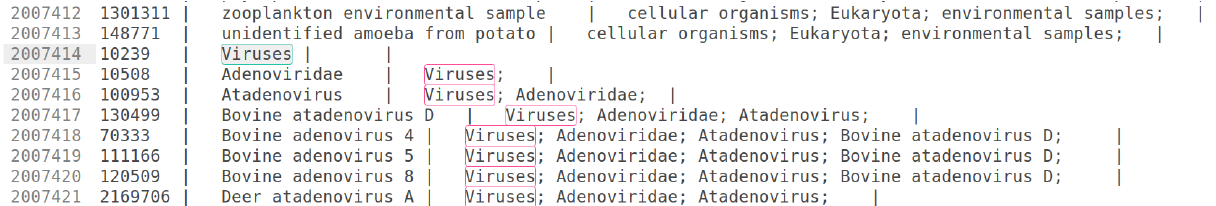
Figure 1. Extract of the virus taxonomy database showing how taxonomic levels are deposited. For many viruses, not each of the taxonomic levels is